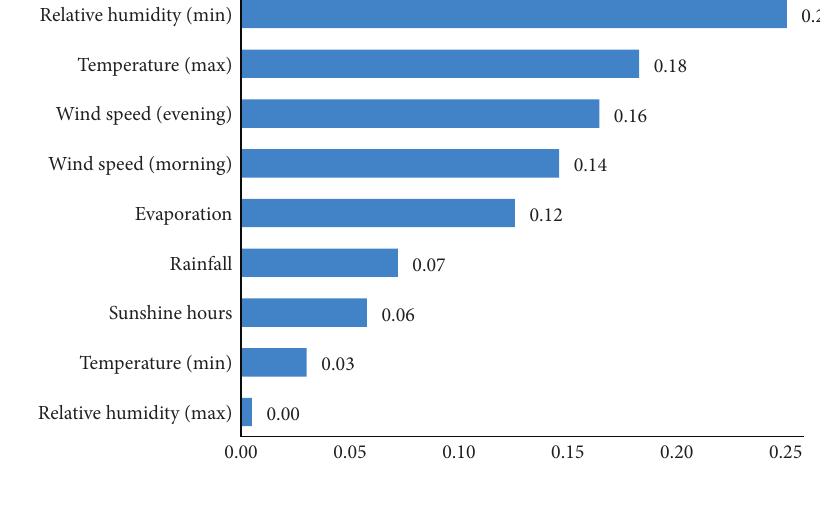
Figure 2: Variable importance.